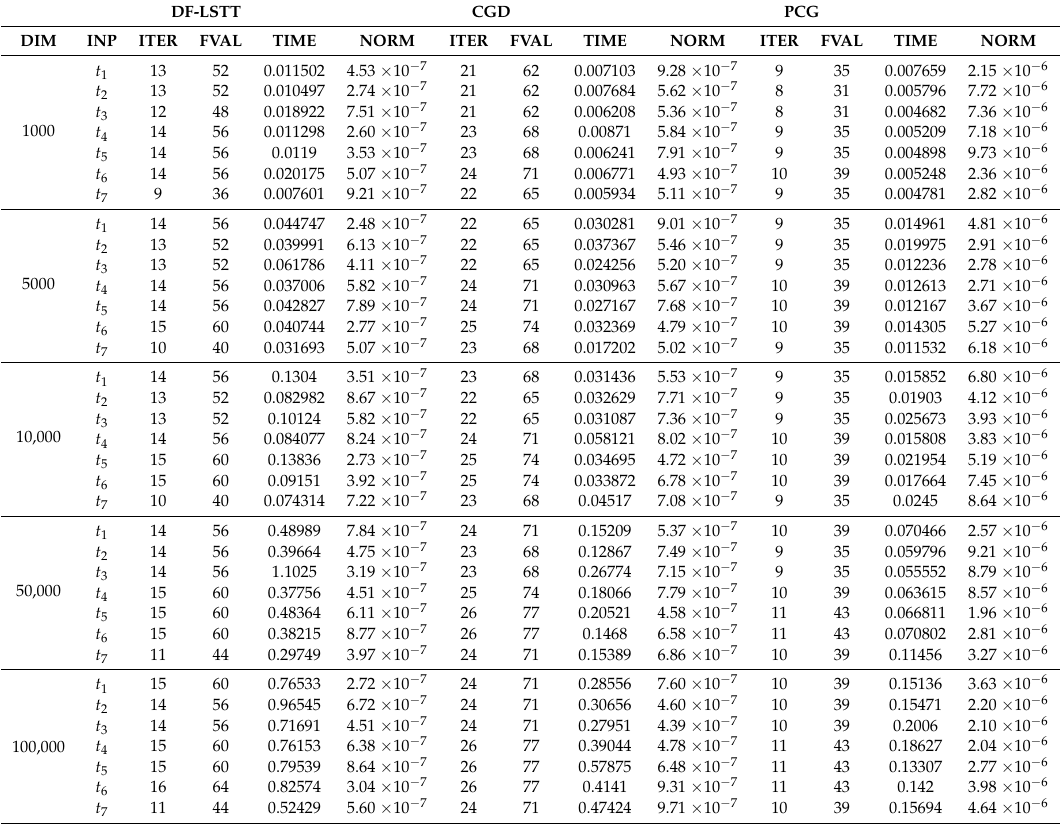
Table 10. Numerical test reports for the three tested methods for Problem